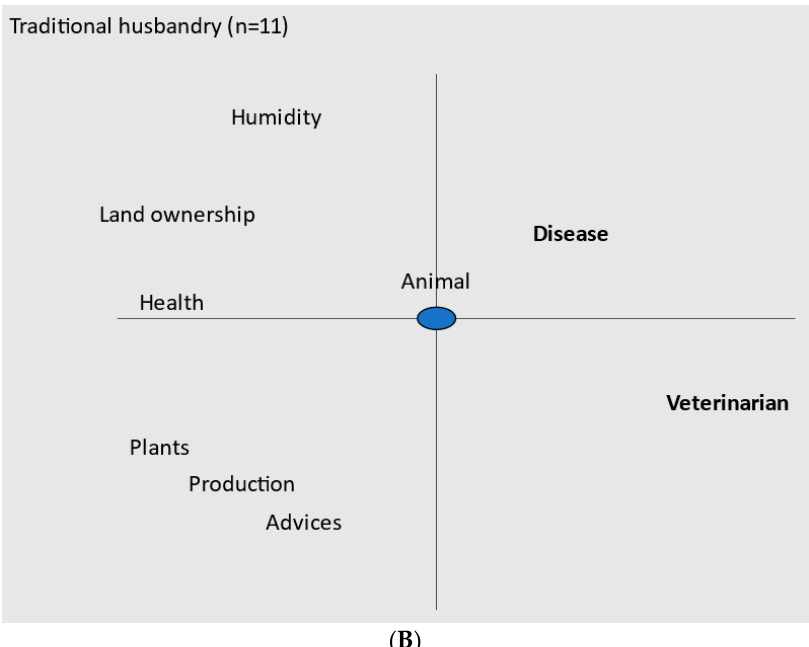
Figure 2. Qualitative content analyses of interviews of farmers practicing professional or traditional husbandry using Tropes software. The analyses were centered on the word animal (or goat); the left part of the figure corresponds to the words appearing before the central word and the left part to the words appearing after the central word; the distance between the central word and other words corresponds to the intensity of the relationship, strong if near or weak when distant. ( A : Professional husbandry/ Agriculture and husbandry) ( B : Traditional husbandry).